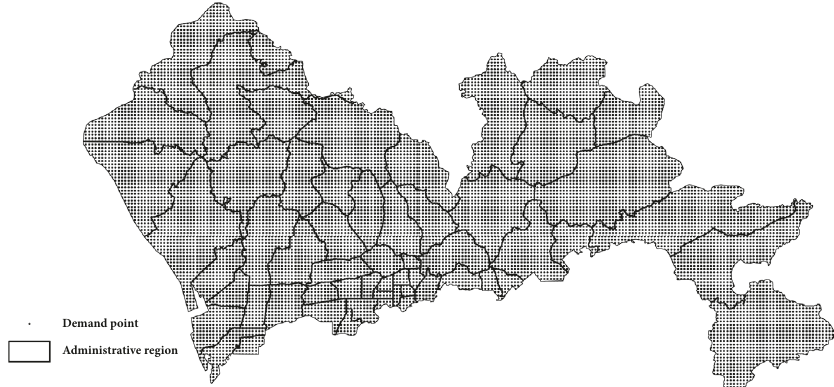
Figure 2: Demand points distribution.